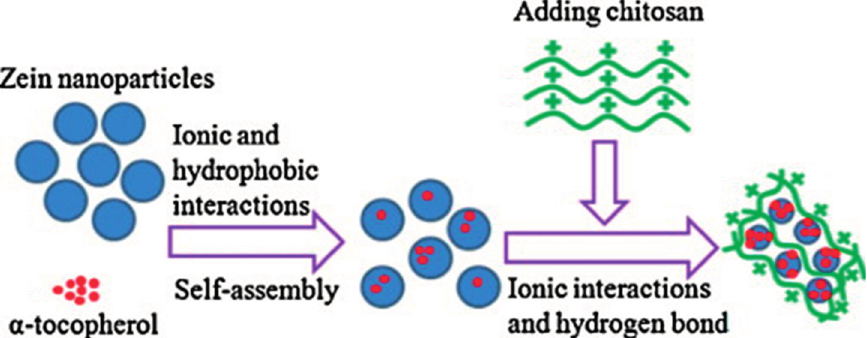
Figure 4. Schematic illustration of the formation of the zein/chitosan complex for encapsulation of α -tocopherol (TOC). Reprinted with permission from [106]. Copyright 2011, Elsevier.